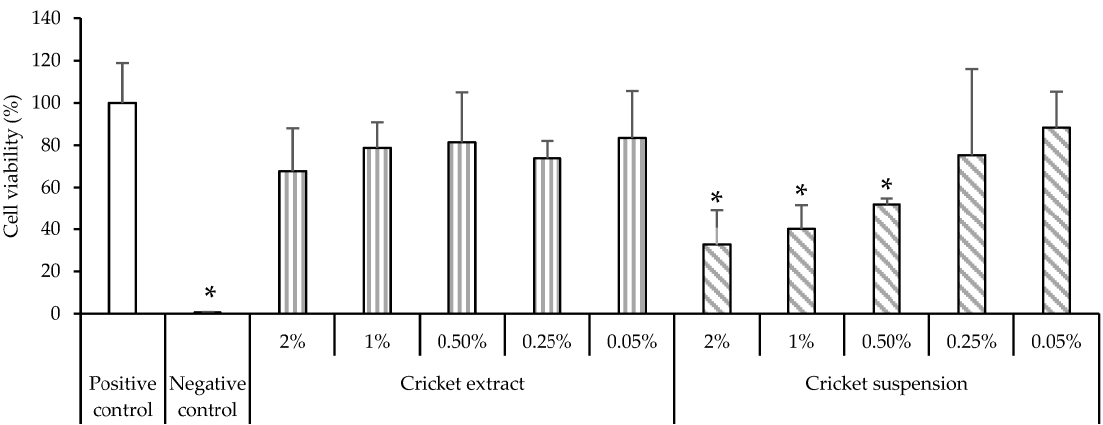
Figure 6. Cell viability of Caco-2 cells after 24 h of contact with cricket extract or cricket suspension (mean ± s.d.; n = 5). * indicates significant differences ( p < 0.05).